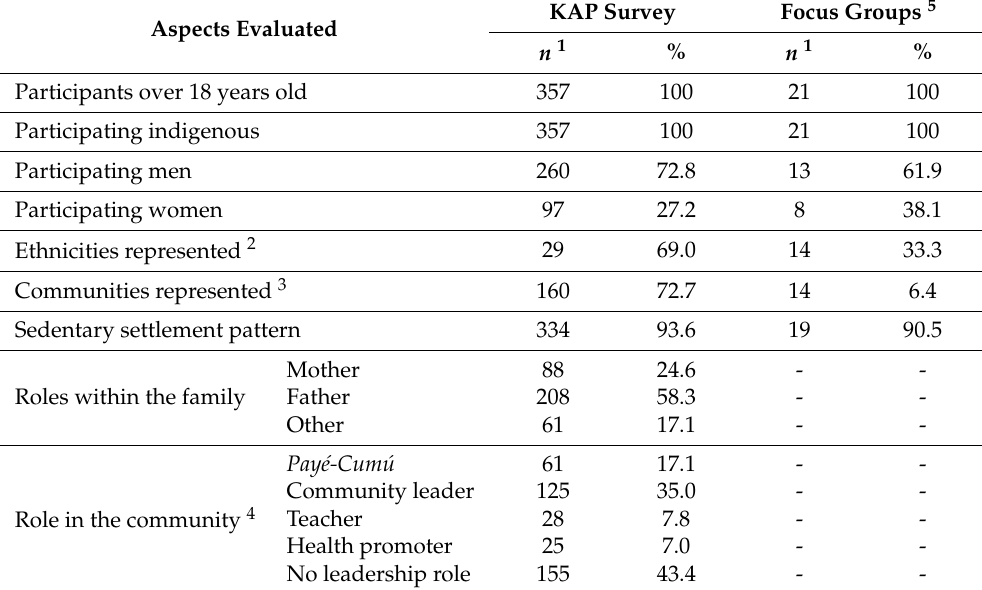
Table 1. The sociodemographic characteristics and the roles of the population studied in terms of the trachoma knowledge, attitudes, and practices survey and focus groups. KAP Survey Focus Groups 5 Aspects Evaluated n 1 Participants over 18 years old Participating